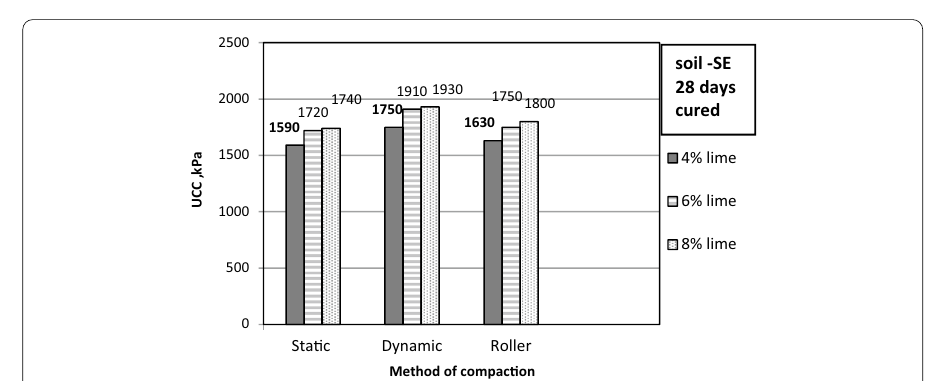
Fig. 8 Effect of methods of compaction on UCS of soil SE treated by lime cured for 28